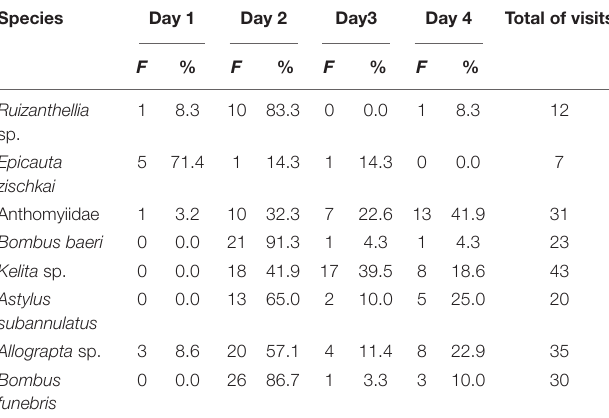
Ruizanthellia sp.